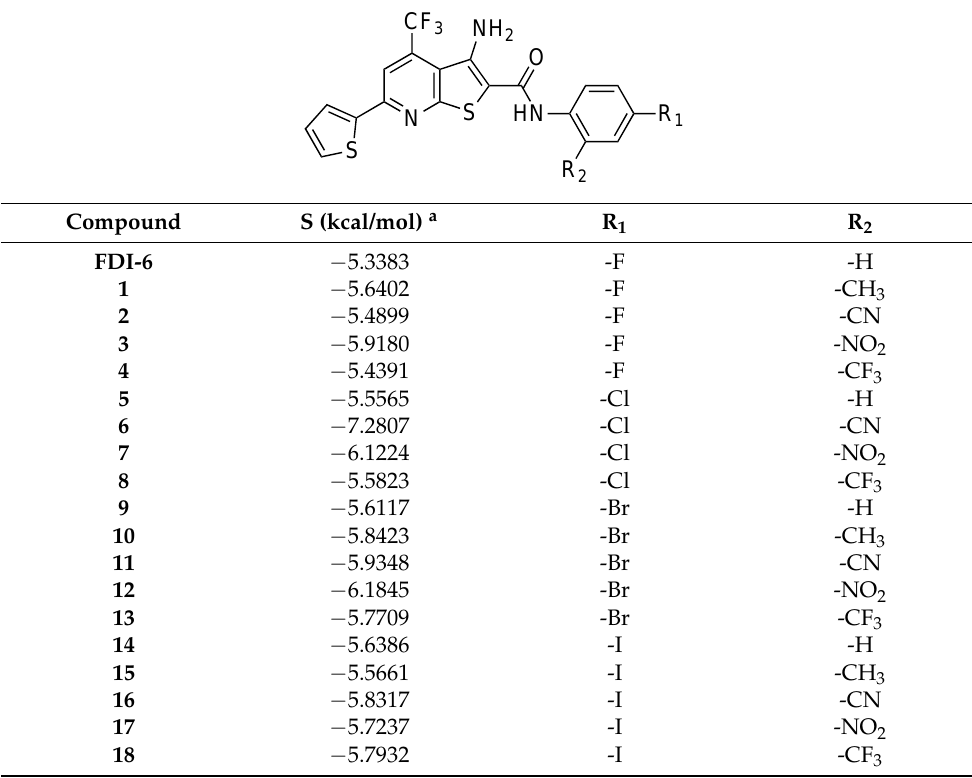
Table 2. Docking scores calculated for the FDI derivatives during the MOE docking protocol.